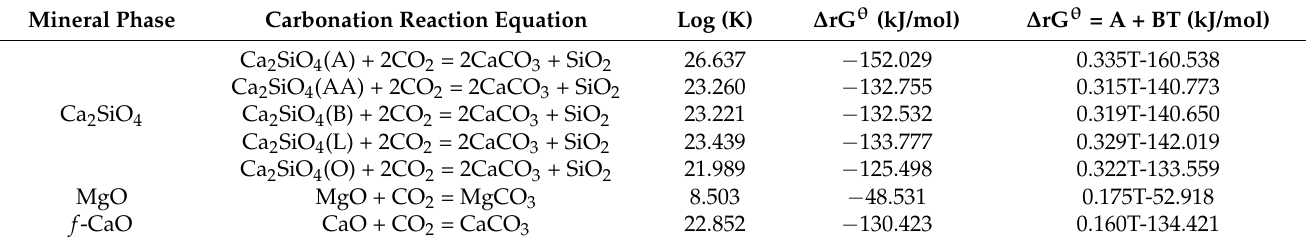
Table 3. Carbonation reaction equations and their Δ rG θ of minerals in AOD slag.